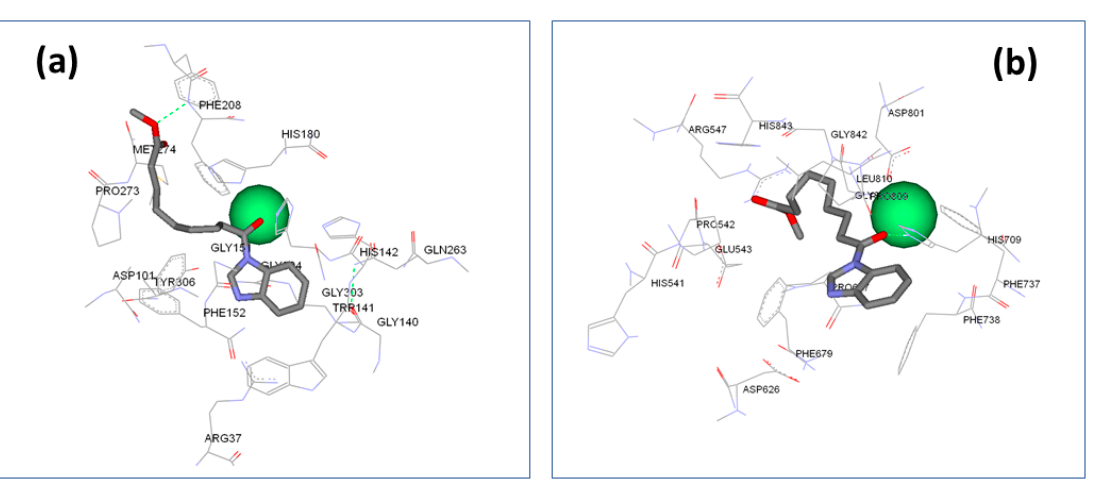
Figure 6. Molecular docking analysis of compound 8a (showing best K i inhibition docking results) with HDAC8 and HDAC7 isoforms. Docking poses of compound 8a in the binding site of ( a ) HDAC8 structure (Protein Data Bank identifier (PDB ID): 4QA3) and ( b ) HDAC7 structure (PDB ID: 3C0Z). In both pictures, the zinc ion is represented as a green sphere .